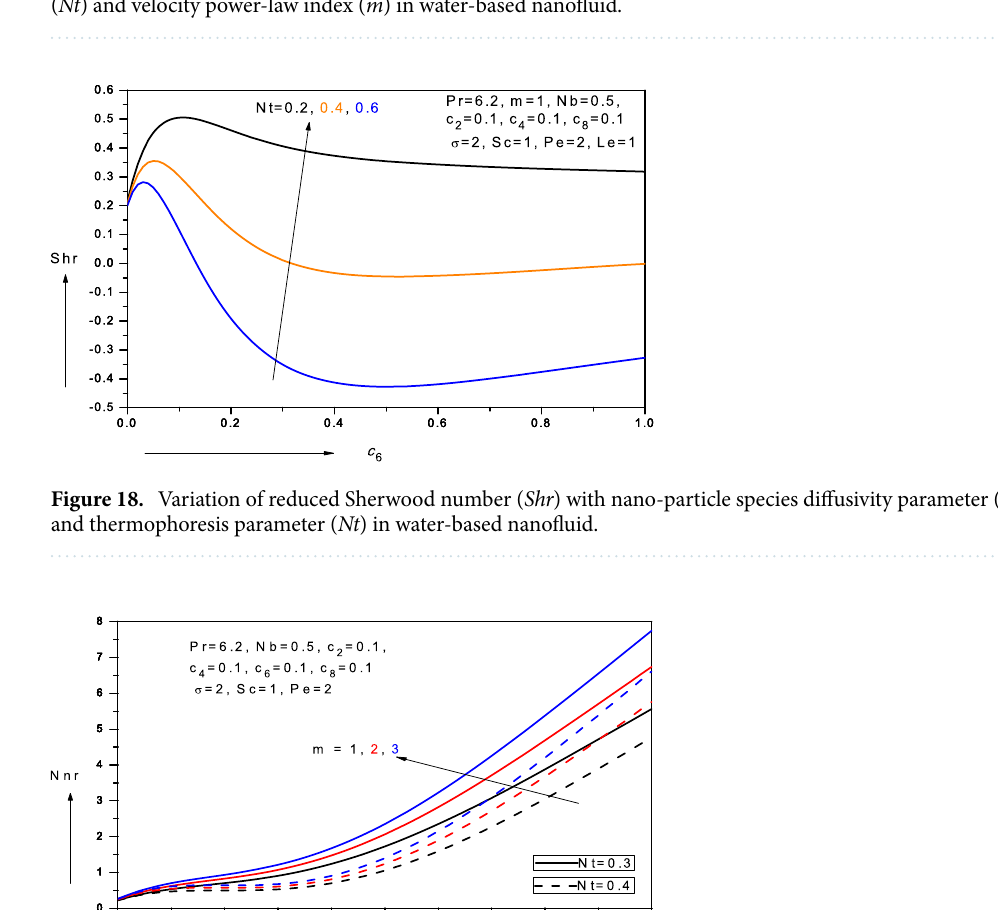
Figure 17. Variation of reduced Sherwood number ( Shr ) with Lewis number ( Le ), thermophoresis parameter ( Nt ) and velocity power-law index ( m ) in water-based nanofluid.